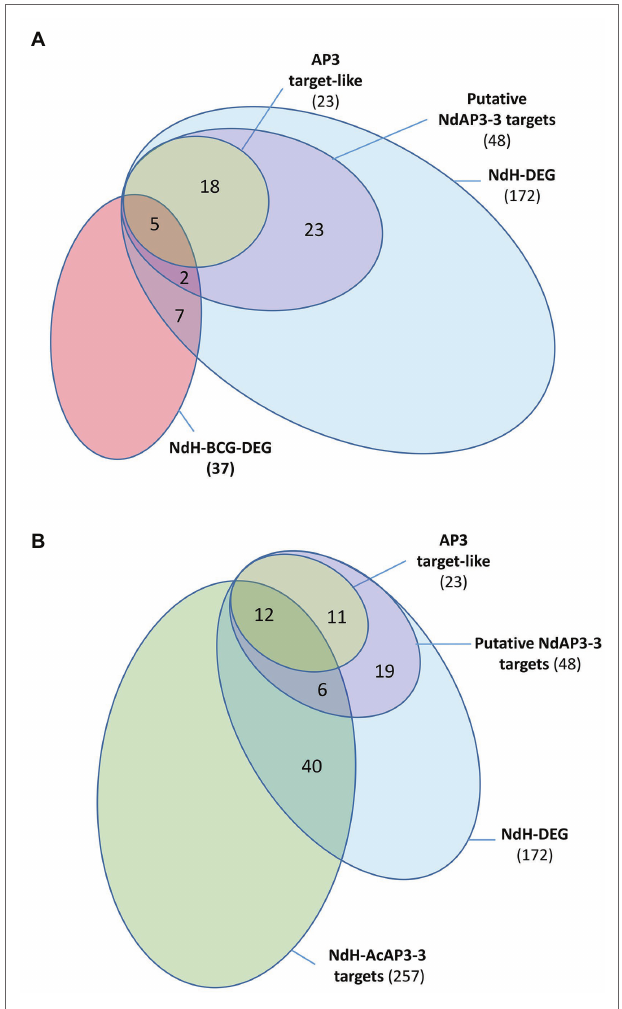
FIGURE 4 | Venn diagram representing the distribution of the Nigella transcripts into subcategories. (A) NdH-DEG and NdH-BCG-DEG are Nigella genes which are differentially expressed between the two morphs and homologous to Arabidopsis genes which are differentially expressed between the wild type and the ap3.3 mutant and the best correlated genes to AtAP3 , respectively. Putative AP3-3 target genes include the best homologs of the AtAP3 target genes (AP3 target-like) and paralogs of AtAP3 target genes in Nigella (see details in Supplementary Table S6 ). (B) NdH-AcAP3-3 are the Nigella best homologs of the Aquilegia AcAP3-3 target genes (see details in Supplementary Table S8 ). The other categories are the same as panel (A)